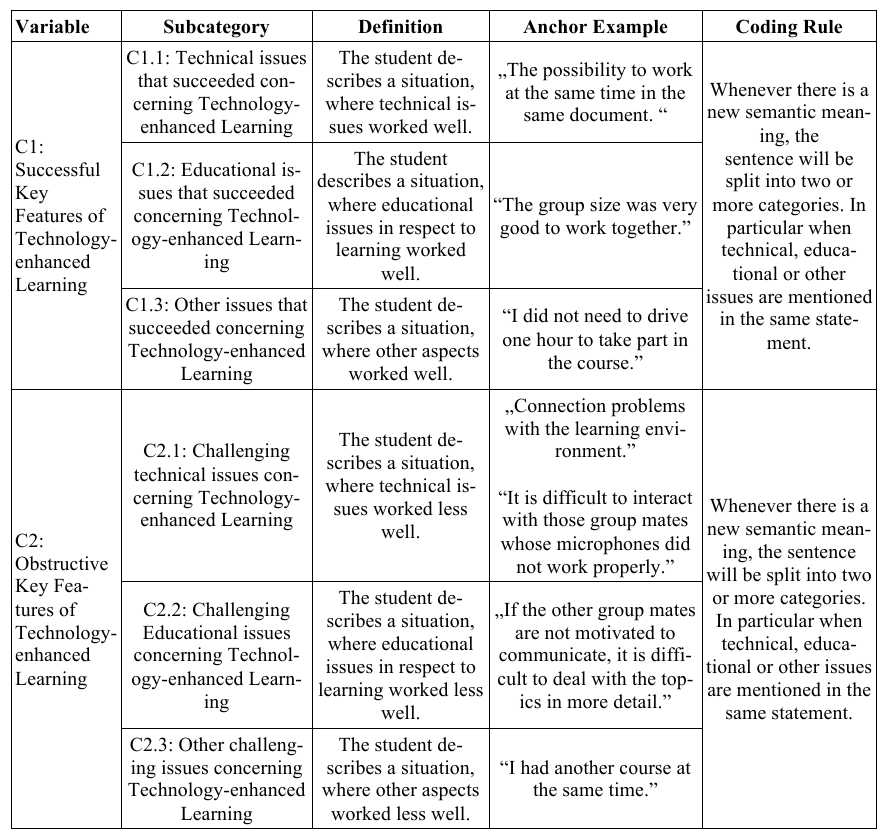
Table 4. Coding guide for qualitative content